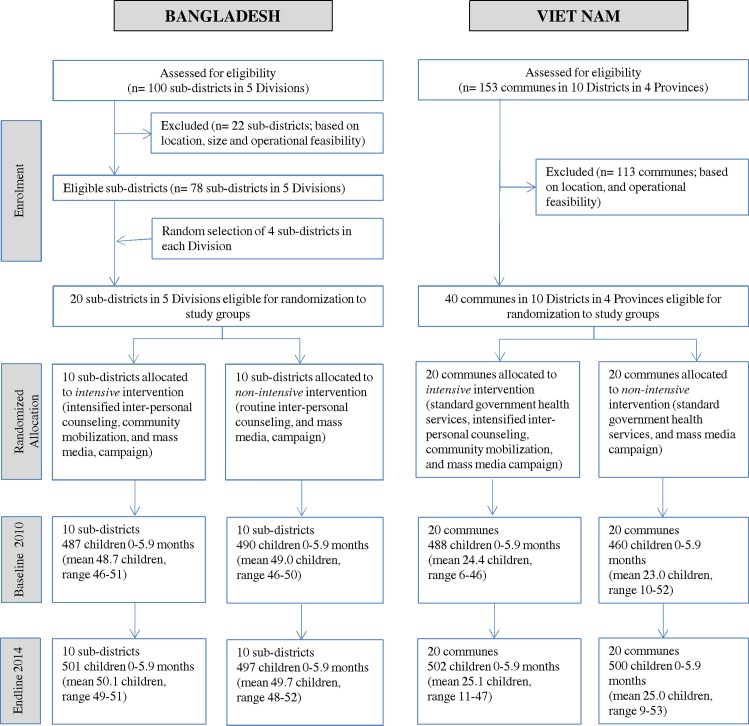
CONSORT diagram.